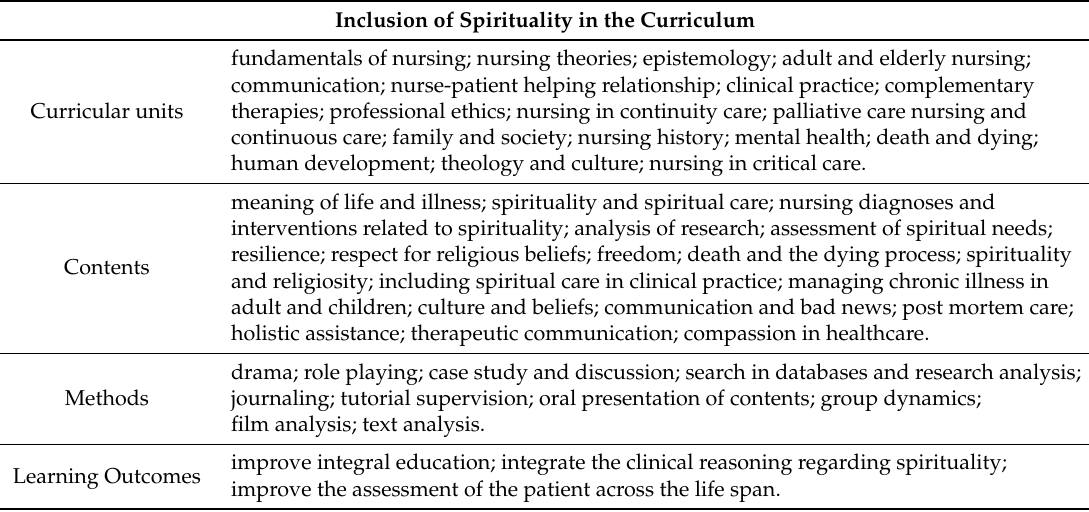
Table 1. Curricular units, contents, methods, and learning outcomes regarding the inclusion of spirituality in the